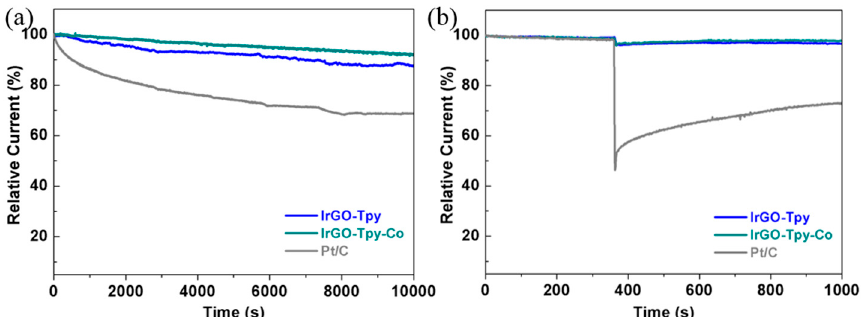
Figure 6. ( a ) Durability tests for IrGO ‐ Tpy, IrGO ‐ Tpy ‐ Co, and Pt/C at a rotation rate of 1600 rpm in O 2 ‐ saturated 0.1 M KOH solution, and ( b ) current–time (j ‐ t) ORR chronoamperometric responses of IrGO ‐ Tpy, IrGO ‐ Tpy ‐ Co, and Pt/C upon the addition of 3 M methanol at around 360